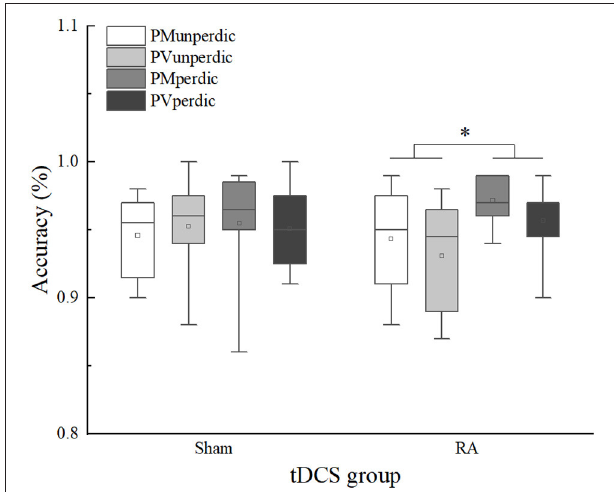
FIGURE 3 | Mixing trials accuracy of sham and right anode (RA) tDCS groups in different task types and task predictability. PMunperdic, the unpredictable parity/magnitude task; PMperdic, the predictable parity/magnitude task; PVunperdic, the unpredictable parity/vowel-consonant task; PVperdic, the predictable parity/vowel-consonant task. * p <